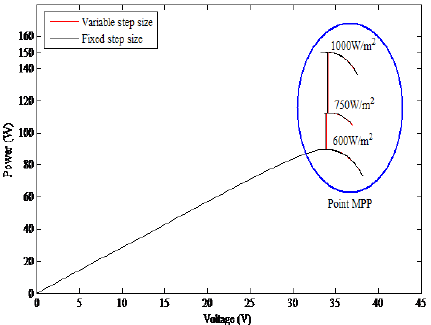
Fig. 14: P-V characteristics.